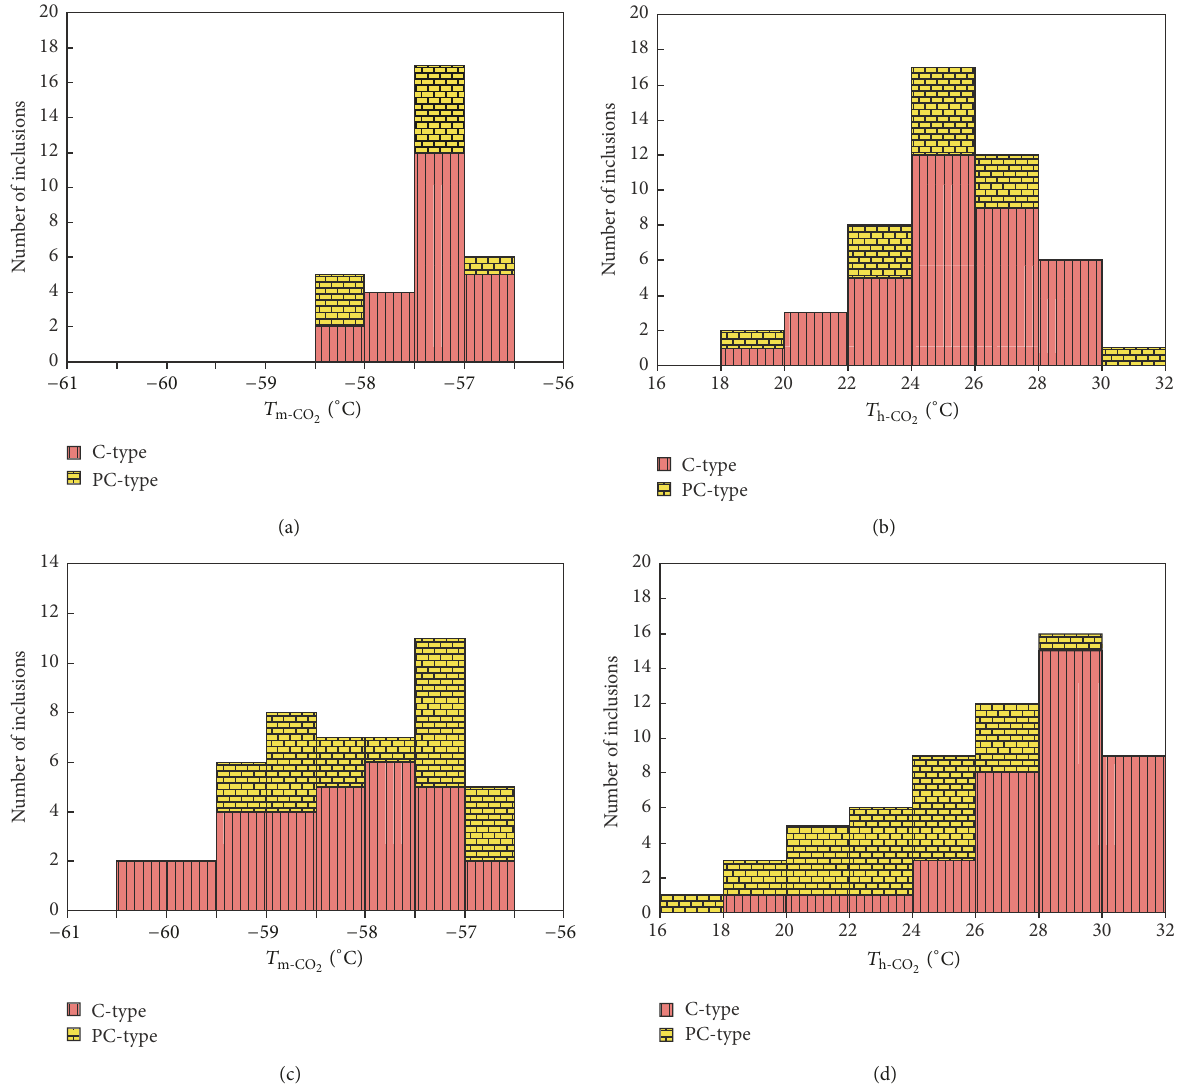
Figure 7: Histograms of CO 2 melting temperatures ( 𝑇 grains and CO 2 homogenization temperature of CO 2 -bearing fluid inclusions in the early stage (b) and middle stage (d) quartz or calcite